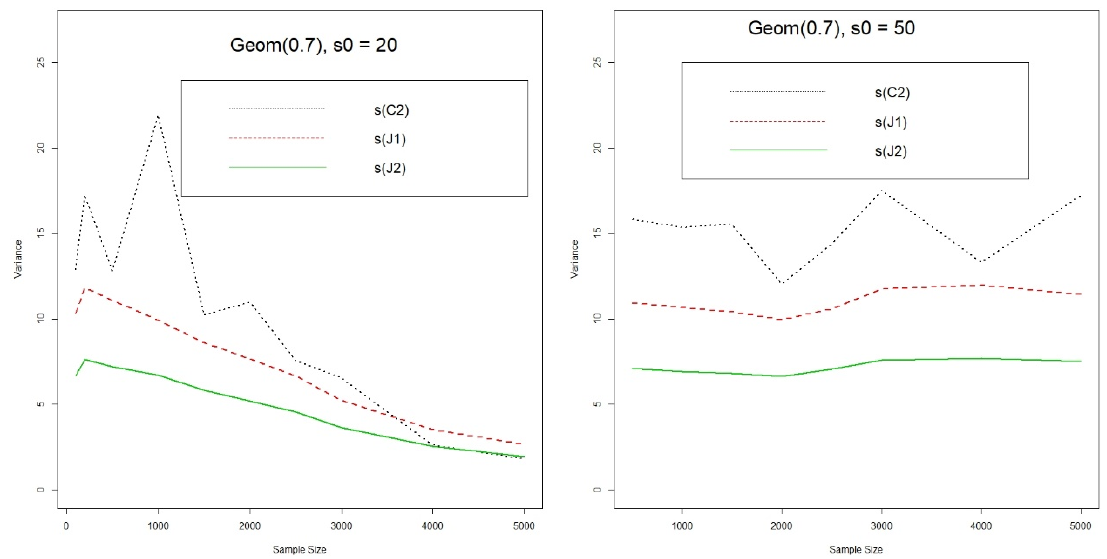
Figure 3. Variance of different Estimates for the Number of Shared Species ( J 1 & J 2: 1st & 2nd Jackknife estimates, C 2: Chao’s estimate, s 0 (n): number of observed shared species).